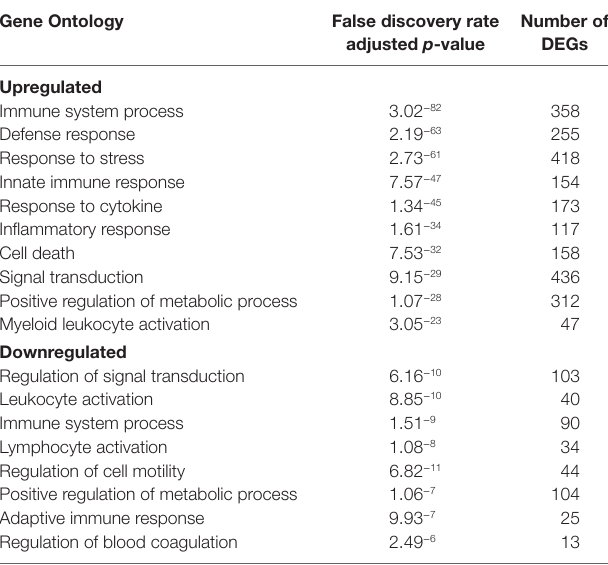
number of adjusted p -value Degs